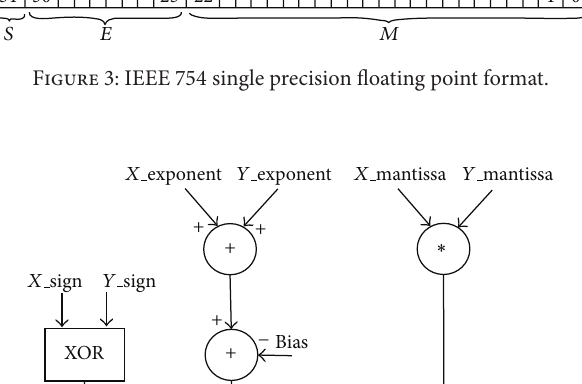
Table 2: Analysis of NCL multipliers.